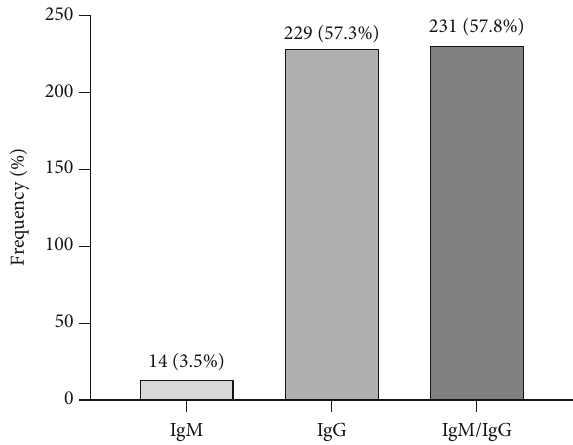
Figure 1: Seroprevalence of Toxoplasma gondii antibodies among the study participants by ELISA. Percentages were calculated from the number of positives over the total number of